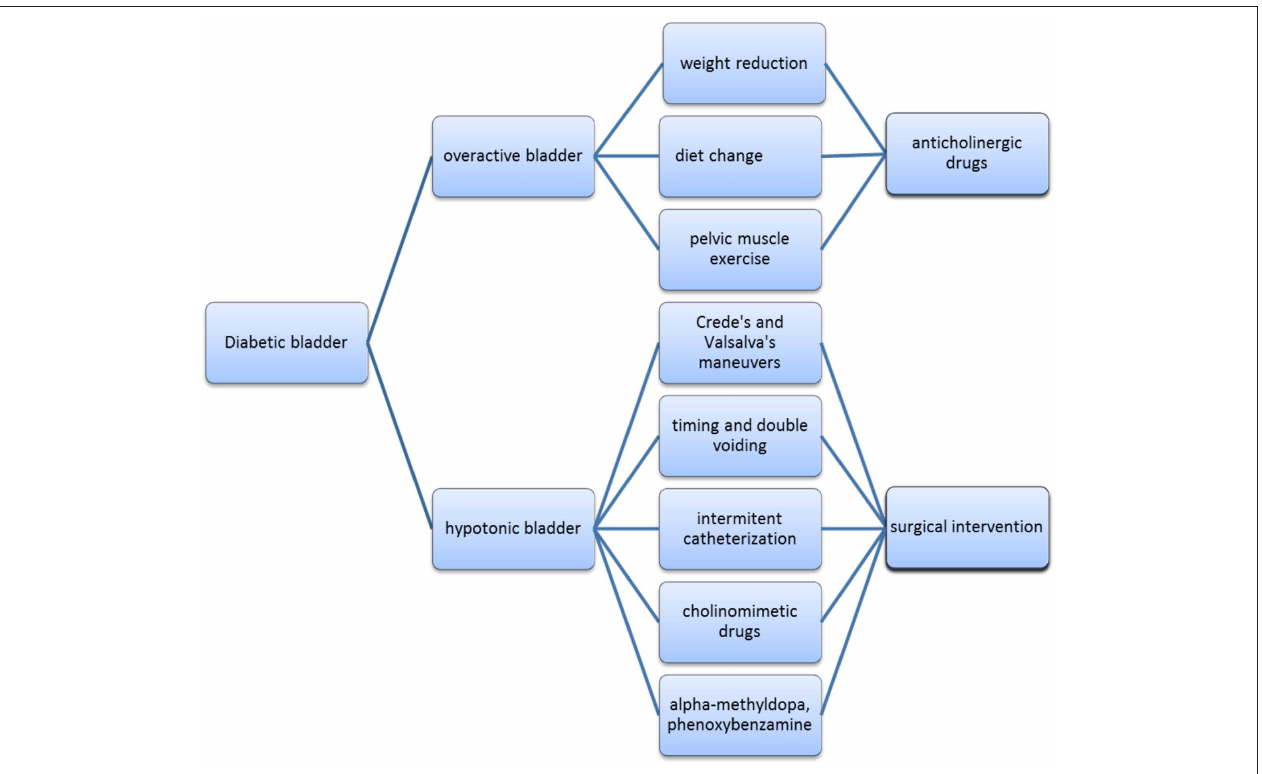
Figure 1 | Treatment levels for diabetic